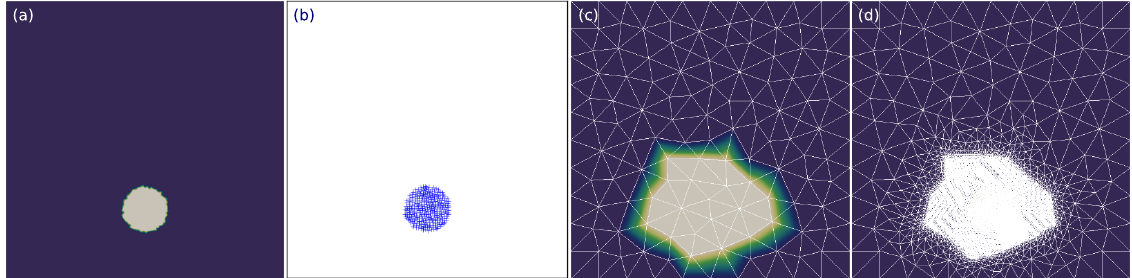
Figure 2. Illustration of mesh refinement. (a) Initial concentration field where bright colours indicate high concentration values. (b) Coor- dinate points of grid locations where concentration exceeds a threshold of 0 . 01. (c) Function that shows high values, indicated by bright colours, at all cells of the coarse mesh that lie within the radius R cells of the respective coordinate points in (b) . (d) Representation of the final refined